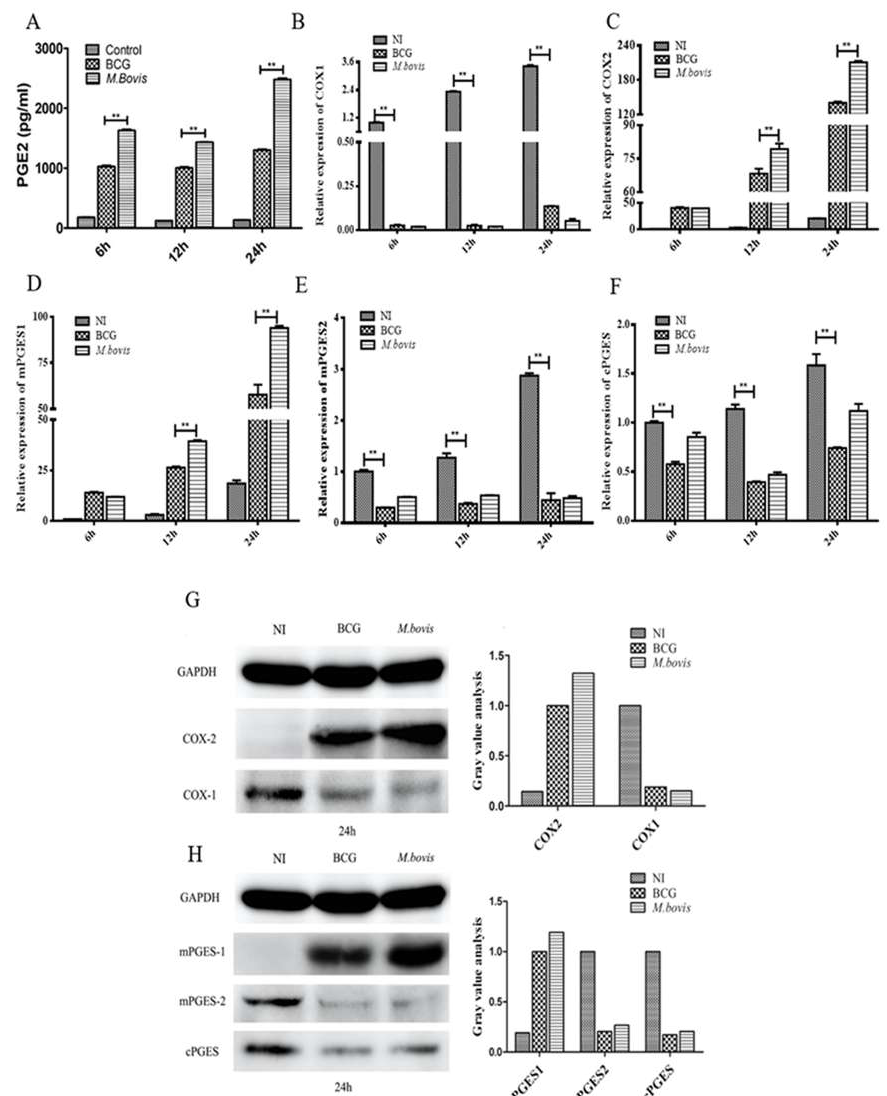
Figure 2. Mycobacterium bovis ( M. bovis ) more strongly activated cyclooxygenase (COX)2-prostaglandin E2 (PGE2) pathways in dendritic cells (DCs) than compared to M. bovis bacillus Calmette-Guérin (BCG). DCs were infected with BCG and M. bovis at a multiplicity of infection (MOI) of 10. ( A ) PGE2 concentrations were measured with commercial ELISA kits at 6, 12, and 24 h post-infection (PI). The relative transcription of COX-1 ( B ), COX-2 ( C ), microsomal PGE2 synthase 1 (mPGES-1) ( D ), microsomal PGE2 synthase 2 (mPGES-2) ( E ), and cPGES ( F ) was measured by real-time RT-PCR at 6, 12, and 24 h PI. The transcription activity of infected DCs was normalized against the uninfected DC control, whose β-actin transcription activity was taken as 1. Protein expression of COX-1/2 ( G ), mPGES-1/2, and cPGES ( H ) was measured with Western blotting and gray value analysis at 24 h PI. The data shown are the mean ± SD of three replicates, where * represents p < 0.05 and ** represents p < 0.01.